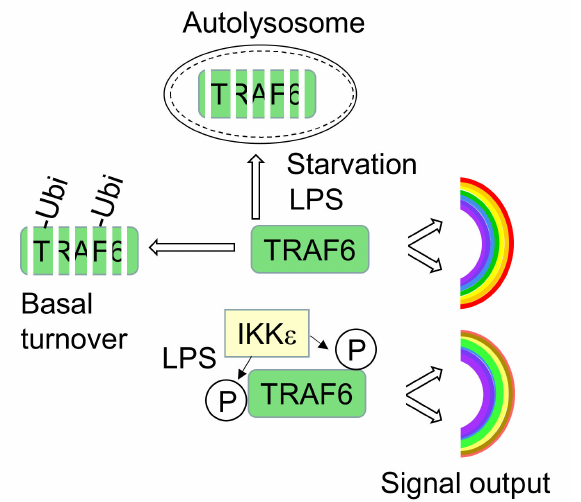
Figure 9. Schematic model summarizing the mechanisms and functions of TRAF6 phosphorylation for protein stability and downstream signaling